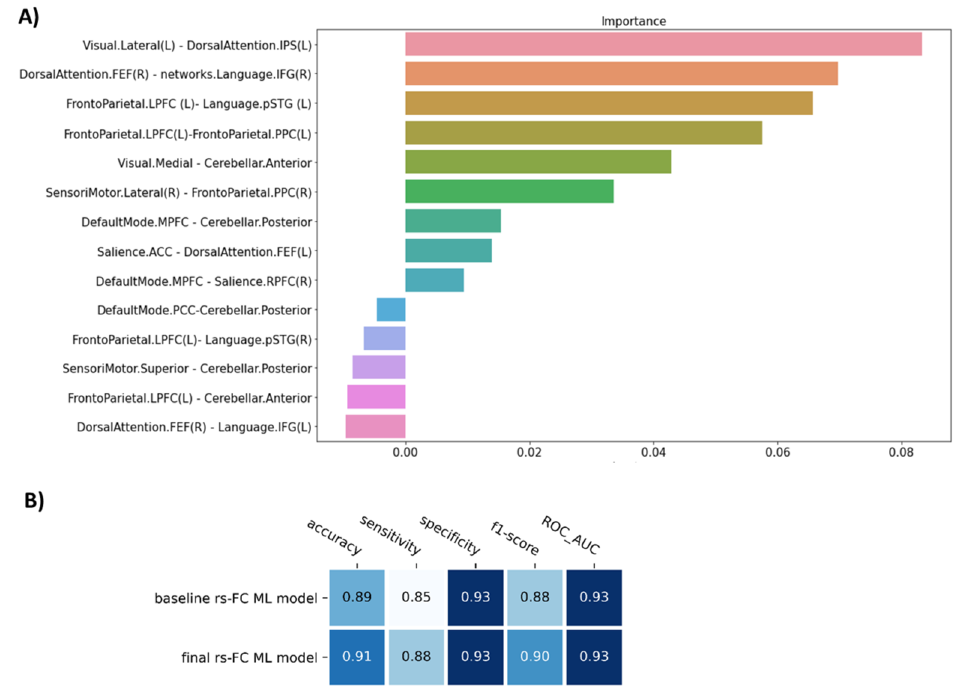
Figure 2. The figure show ( A ) The important feature ranking in the baseline model of resting-state functional connectivity data and ( B ) The performance of the model before (baseline rs-FC ML model) and after removing non-informative features (final rs-FC ML model). Note: Visual.Lateral (L) and Visual.Medial = the left lateral visual network and the medial visual network; DorsalAttention.IPS (L) and DorsalAttention.FEF (R) = the left intraparietal sulcus node and frontal eye field node of dorsal attention network; Language.IFG and Language.pSTG = the inferior frontal cortex node and the posterior superior temporal gyrus node of language network; Frontoparietal.LPFC and Frontoparietal.PPC = the lateral prefrontal cortex node and the posterior parietal cortex node of frontoparietal network; Cerebellar.Anterior and Cerebellar.Posterior = anterior and posterior node of cerebellum; SensoriMotor.Lateral and SensoriMotor.Superior = the lateral sensorimotor network and the superior sensorimotor network; DefaultMode.MPFC and DefaultMode.PCC = the medial prefrontal cortex node and posterior cingulate cortex node of the default mode network; Sali- ence.ACC and Salience.RPFC = the anterior cingulate cortex node and the rostral prefrontal cortex node of the Salience network.